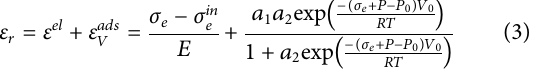
Table 3 , to predict swelling stresses ( σ sw ) developed in VD SWy-1 montmorillonite charged with dry CO 2 at 10 MPa at 50 ° C under restricted swelling strain ( ε sw ) conditions, i.e. under the same conditions and same restricted swelling strain condition as the swelling stress experiments reported in Zhang (2019) ( see Table 4 ). First, we combine the Hol-Liu-Spiers model with Hook ’ s Law to establish a relationship between (total) restricted sample strain ( ε r ) and the effective stress applied,